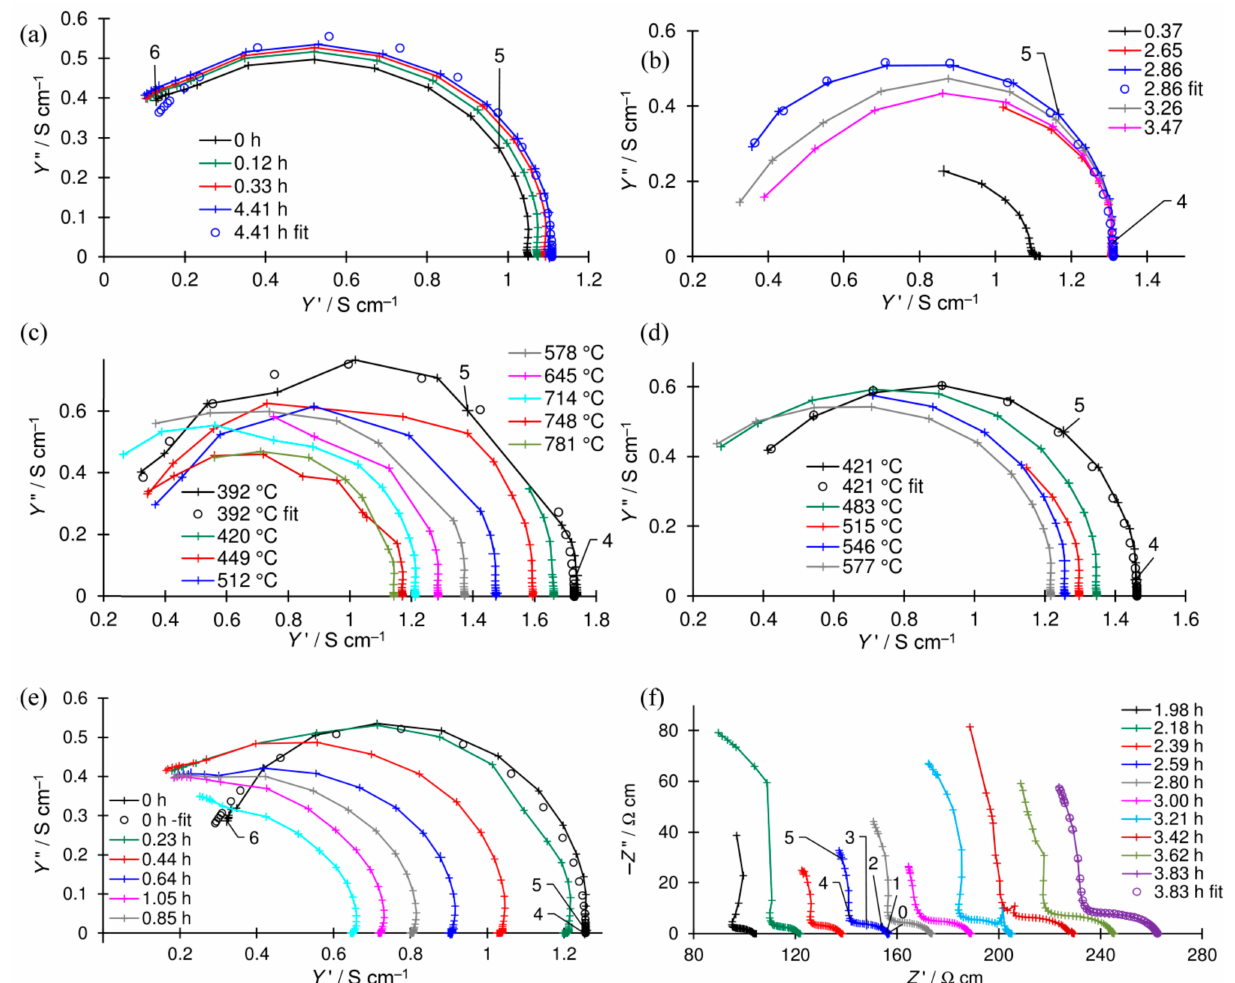
Figure 13. Examples of admittance ( a – e ) and impedance spectra ( f ) during: ( a ) the first and ( b ) second reductions in 5% H 2 ; ( c ) heating and ( d ) cooling; during oxidation in wet air ( e ) before and ( f ) after the loss of metallic conductivity (crosses—measured data, circles—fitted data). The numbers above the magnified symbols represent the logarithm of the frequency. In ( a , b , e , f ), the legend shows the time elapsed from the beginning of the measurement. In ( c , d ), it shows the